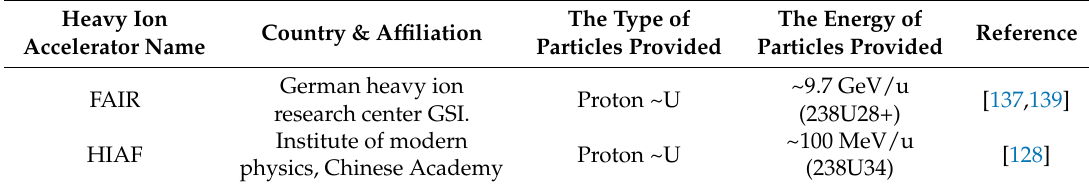
Table 9. Heavy ion accelerators under